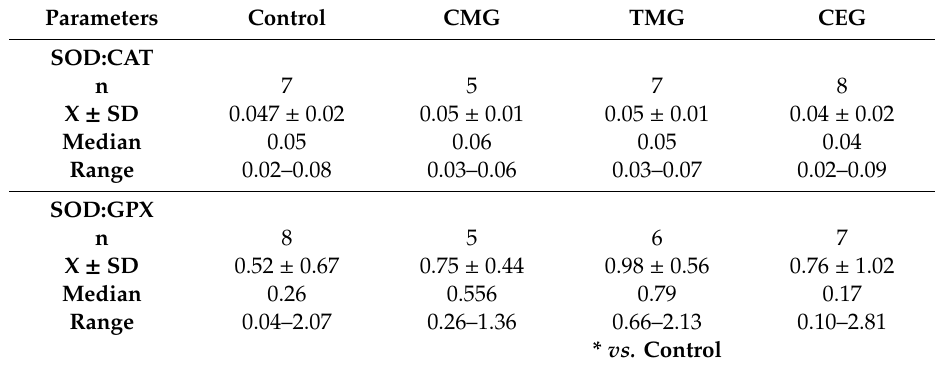
Table 4. The SOD:CAT and SOD:GPX activity ratios for hepatic tissue in the control, CMG, TMG, and CEG